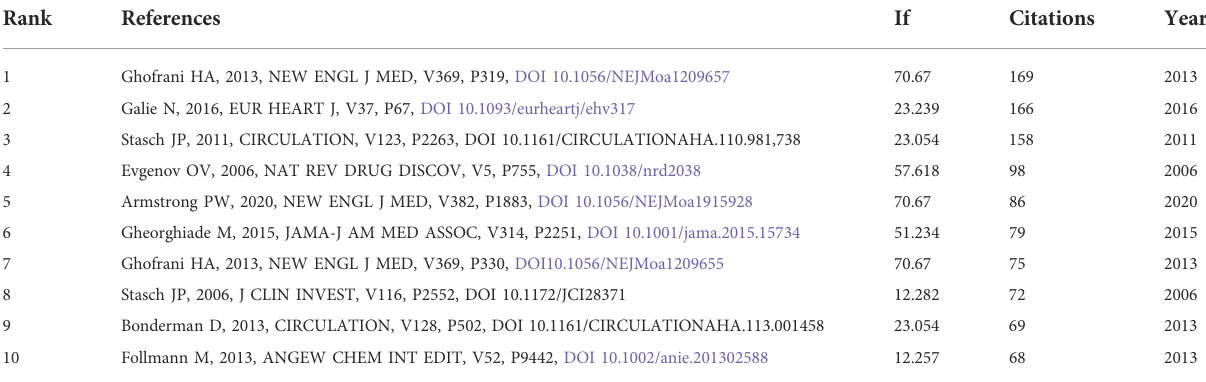
TABLE 5 Top 10 co-cited references in cardiovascular research of sGC stimulators from 1992 to